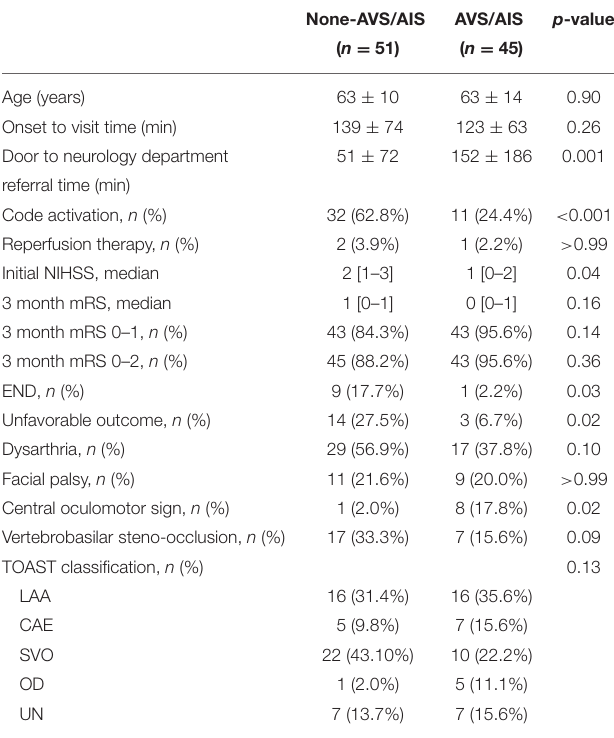
TABLE 3 | Demographics and clinical characteristics of patients with minor posterior circulation stroke.